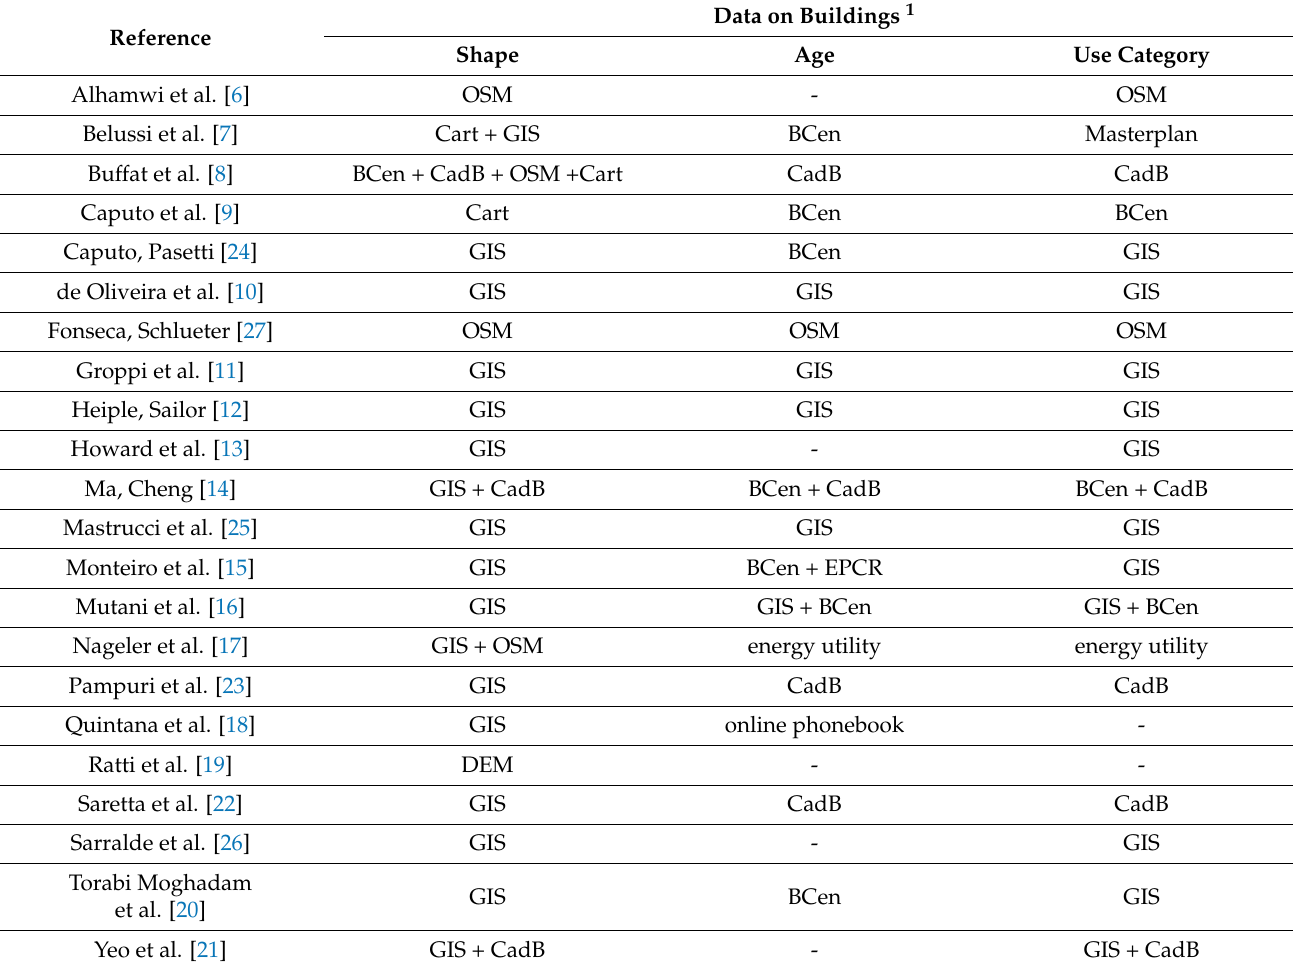
Table 1. Buildings’ data and sources in GIS-based procedures of the selected technical